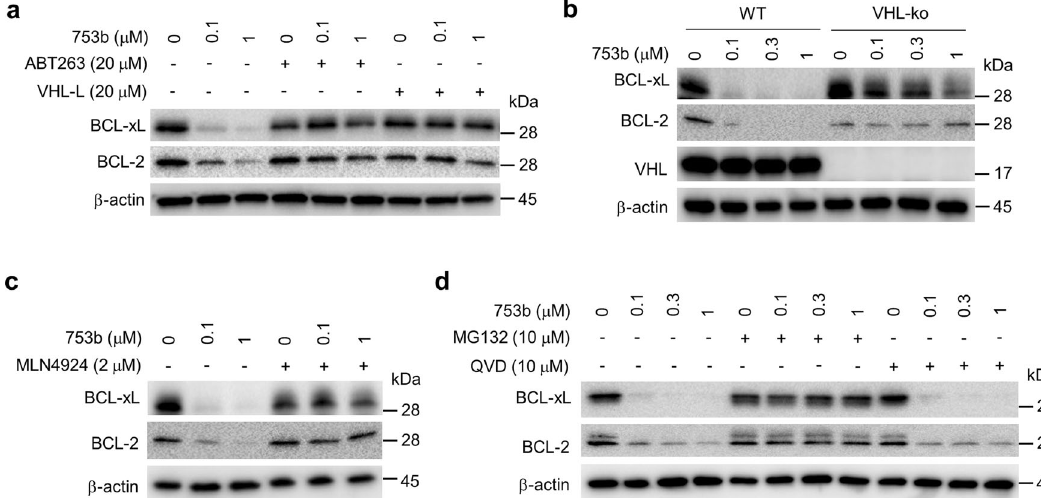
Fig. 4 753b degrades BCL-xL/2 in a VHL- and proteasome-dependent manner. a Pretreatment with ABT263 or VHL-L blocks the BCL-xL/2 degradation induced by 753b in 293T cells. b CRISPR knockout of VHL blocks 753b-induced BCL-xL/2 degradation as shown in wild type (WT) and VHL knockout (VHL-ko) 293T cells. c Inhibition of CRL VHL neddylation with MLN4924 blocks BCL-xL/2 degradation induced by 753b in 293T cells. d Inhibition of proteasomes with MG132, but not that of caspases with the pan-caspase inhibitor QVD, blocks 753b-induced BCL-xL/2 degradation in 293T cells. Source data are provided as a Source data fi